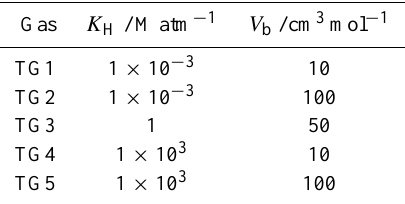
Table 4. Input parameter values for test gases used in sensitivity analysis. Note that − 1 H , the temperature dependence of the solu- R bility, is fixed at an average value of 5000K −